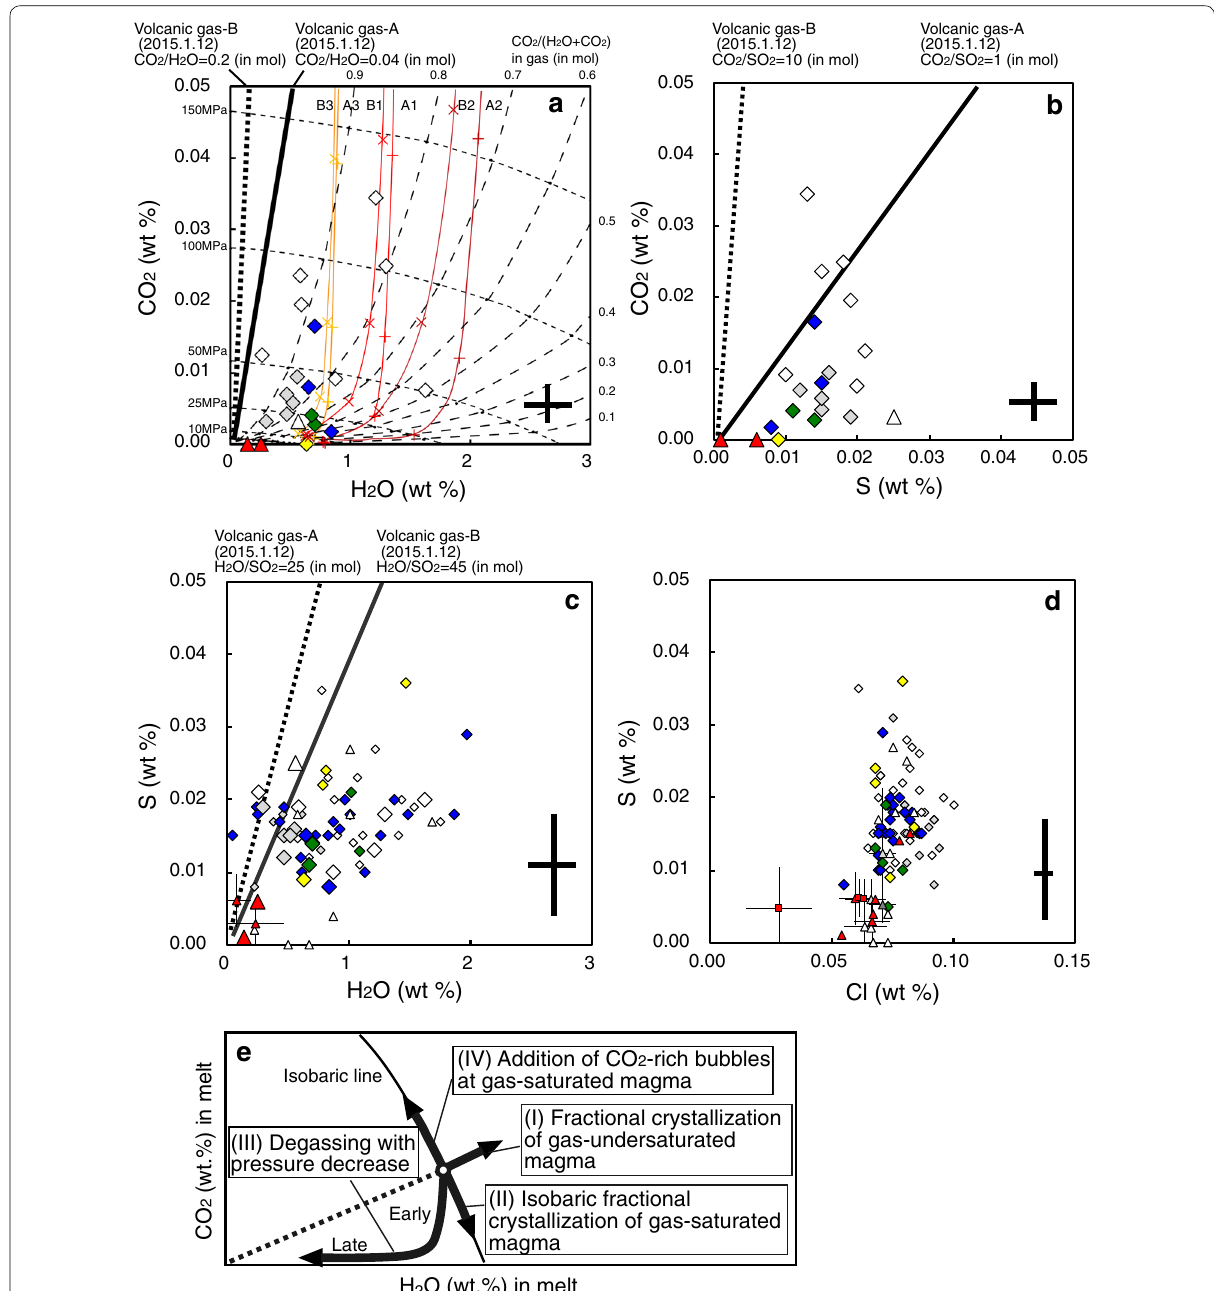
Fig. 6 Volatile content of melt inclusions and glass in the groundmass in the scoria. The CO 2 /H 2 O, CO 2 /SO 2 , and H 2 O/SO 2 ratios of the volcanic gases are shown as solid lines (type A) and dashed lines (type B). a H 2 O and CO 2 content of the melt inclusions analyzed by SIMS. H 2 O and CO 2 contents of the melt of the A1, A2, A3, B1, B2, and B3 magmas calculated by MELTS at 1079 °C (Table 5; Additional file 3: Table S2) are also shown. b S and CO 2 contents of the melt inclusions. c H 2 O and S contents of the melt inclusions. d Cl and S contents of the melt inclusions. e Possible evolution processes of H 2 O and CO 2 in a magma chamber for (I) fractional crystallization of gas-undersaturated magma, (II) isobaric fractional crystallization of gas-saturated magma, (III) degassing with pressure decrease, and (IV) addition of CO 2 -rich bubbles to gas-saturated magma (Saito et al. 2001). Process (III) causes an initial drastic decrease in CO 2 concentration (as shown by “Early”), which is followed by a decrease in H 2 O concentration (as shown by “Late”) because of the lower solubility of CO 2 compared with H 2 O. The symbols are the same as in Fig. 5. Error bars indicate the analytical errors of H 2 O and CO 2 by SIMS and those of S and Cl by EPMA. The analytical error of H 2 O by EPMA in ( c ) is 1 ±